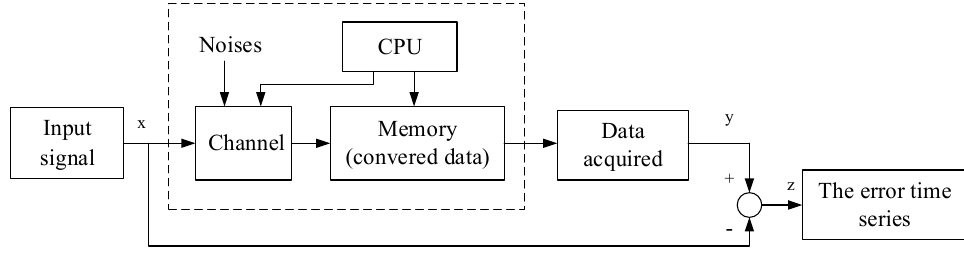
Figure 1. The acquisition principle of error time series with a single input signal.